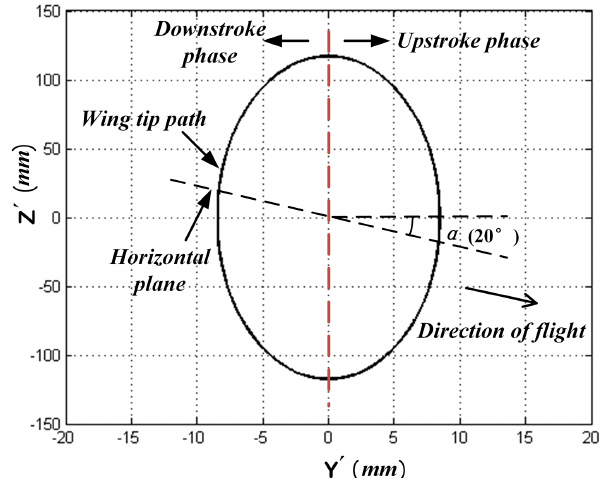
Figure 4. Schematic illustration of flapping-wing mechanism at the forth extreme position. Figure 5. Wing-tip path as seem from X (cid:48) -axis direction